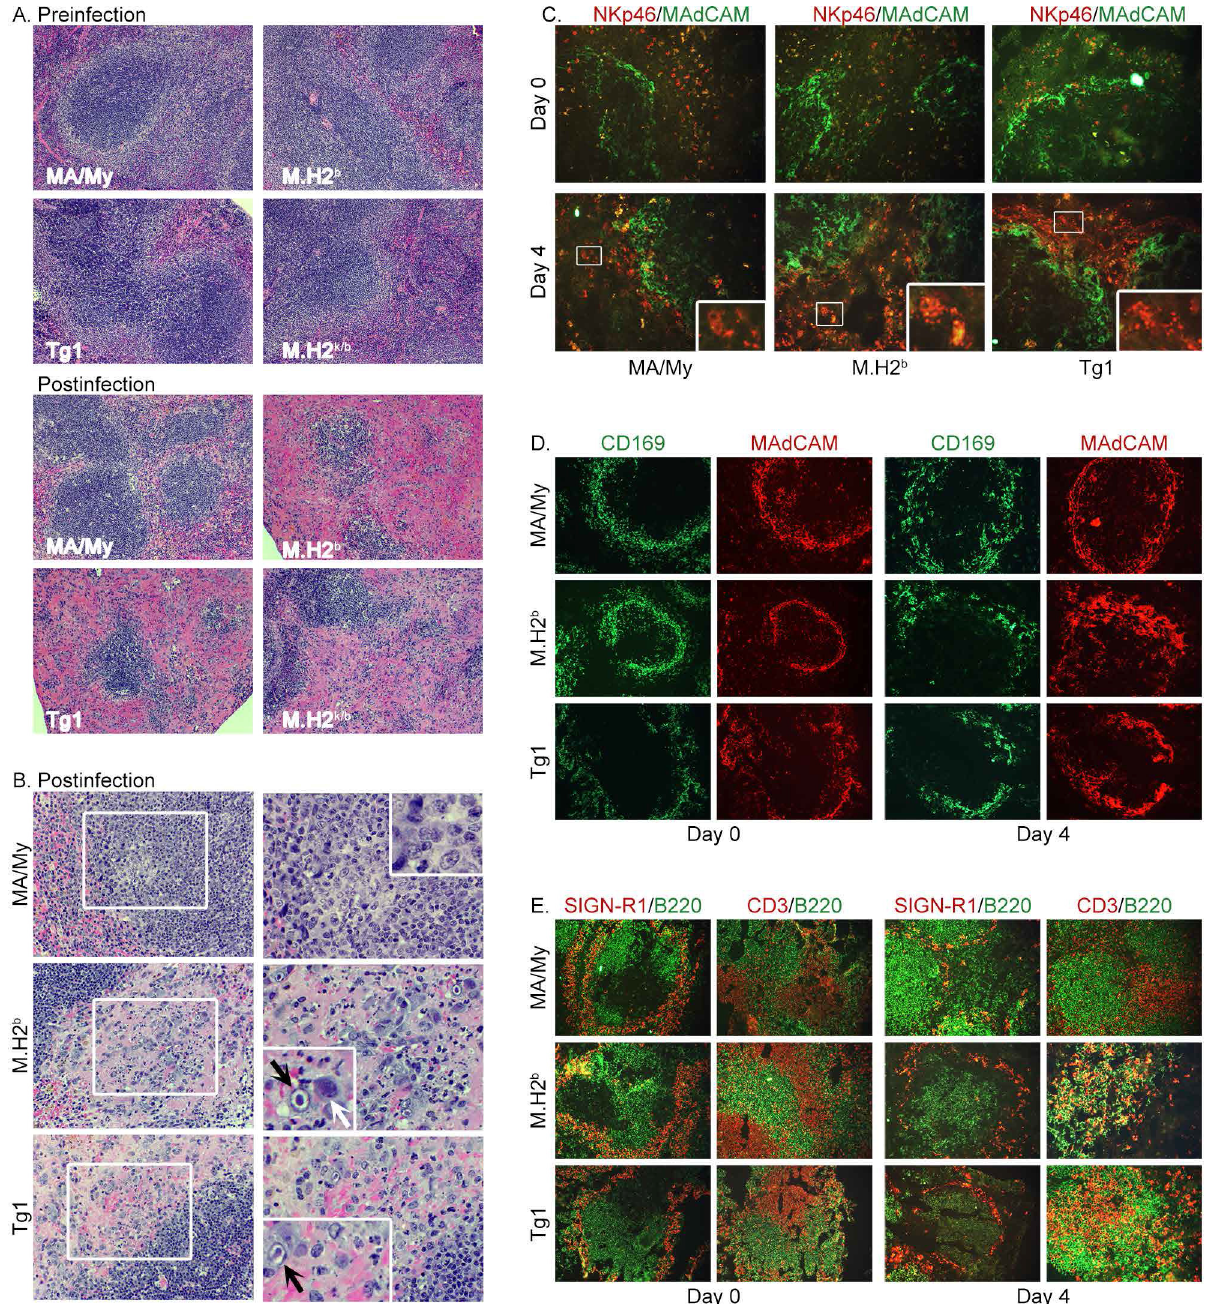
Fig 5. Cmv5- dependent protection of SLO structures and lymphoid remodeling in spleen during acute MCMV infection. (A and B) H&E-stained tissue sections obtained from uninfected and HD-infected (d 3.5) spleens of MA/My-related mice (magnification, (A) X100; (B) X200 or X400 with X800 insets). Images of infected spleen are representative of 4 to 8 mice per group in two independent experiments. Diminished SLO structural integrity is evident by comparison of WP and MZ regions, in addition to severe necrosis apparent in RP regions of spleens from the different strains. Pseudo-nodules of leukocytes heterogeneous in size and found near the MZ in MA/My mice frequently contained activated and mitotic figures inside square at low magnification on left, and at higher magnifications on right. Cytomegalic inclusions (black arrow) and plasmacytoid-like cells (white arrow) frequently detected in TgD k and M.H2 b spleens are indicated (insets in right panels). (C-E) Frozen spleen sections stained with fluorescence-conjugated mAbs against NKp46 + NK cells and MAdCAM + marginal sinus lining cells (magnification X200 with X600 insets) (C), MAdCAM + or CD169 + MZ macrophages (magnification X100) (D), and both SIGN-R1 + MZ macrophages and B220 + B cells or CD3 + T cells and B220 + cells (magnification X100) (E, see text for